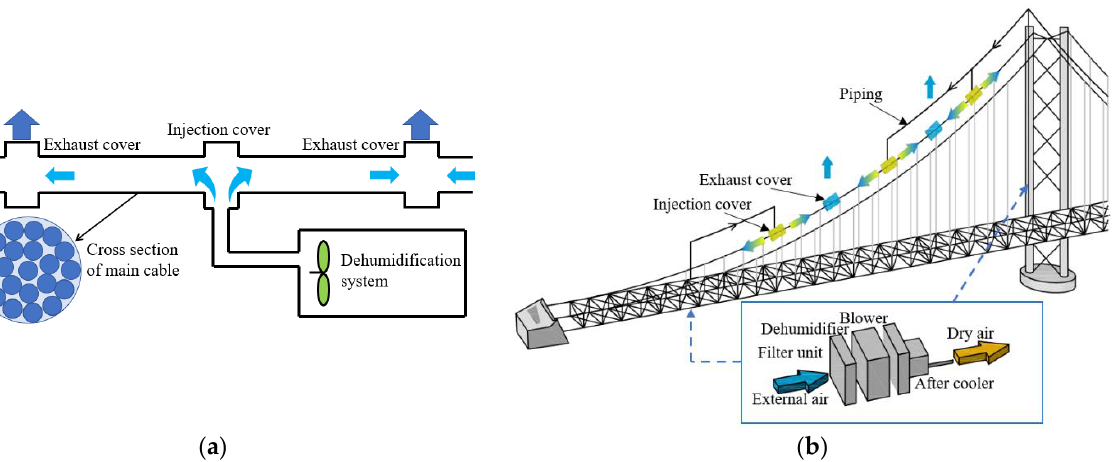
Figure 1. The principle of main cable dehumidification. Reprinted/adapted with permission from Ref. [12]. 2021, Elsevier. ( a ) The flow of air inside the main cable. ( b ) Layout of the cable dehumidi- fication system.